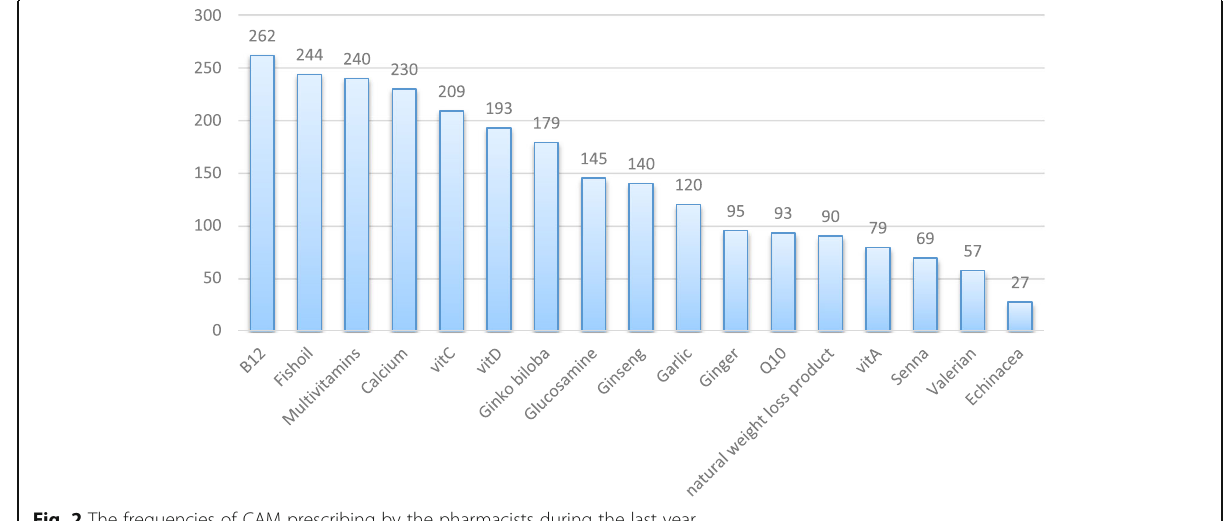
Fig. 2 The frequencies of CAM prescribing by the pharmacists during the last year